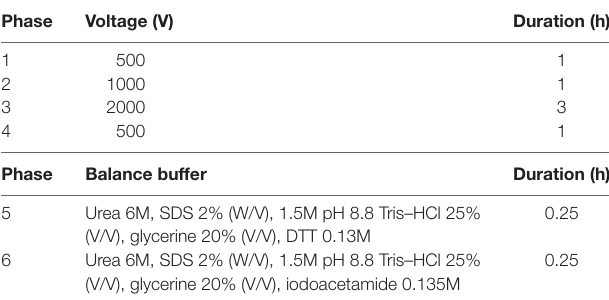
TaBle 1 | The protocol isoelectric focusing of protein